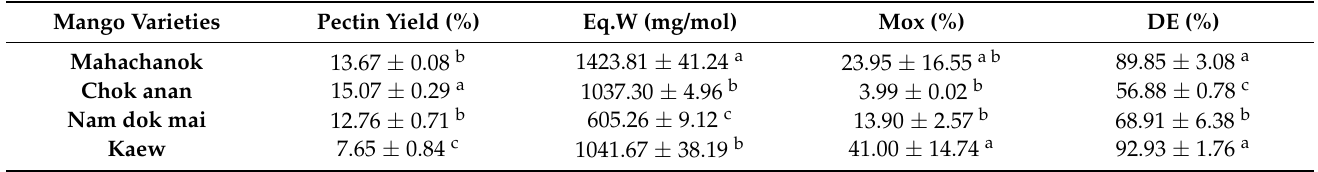
Table 4. Chemical characteristics of mango peel from different